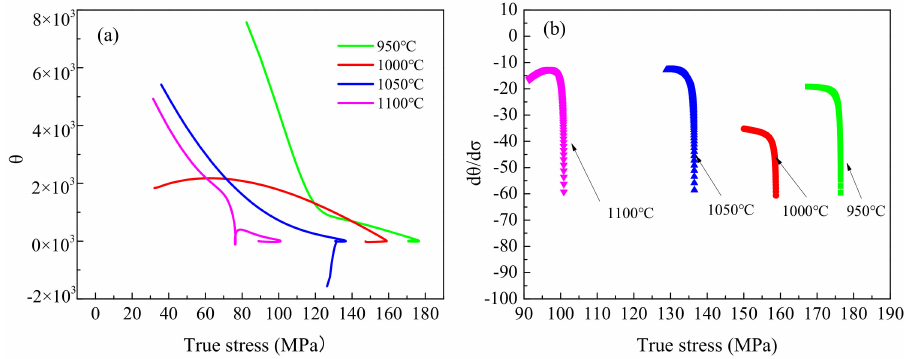
Figure 9. ( a ) θ - σ curves and ( b ) d θ / d σ - σ curves of the coarse-grained specimens at a strain rate of 0.01 s − 1 for di ff erent deformation temperatures.